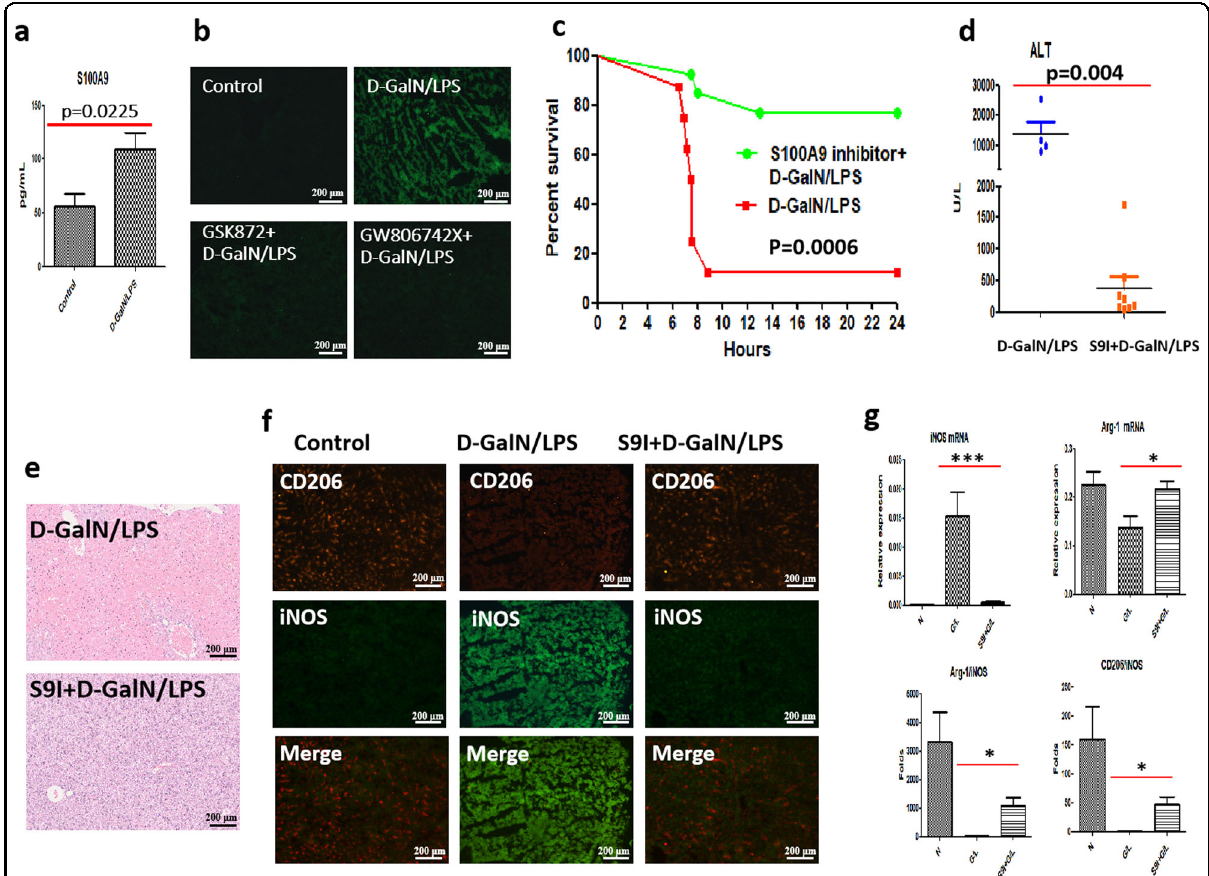
Fig. 3 The inhibition of S100A9, a downstream player of necroptosis signaling, alleviates acute hepatic injury, which is relevant to M2-like activation of macrophages. a Serum S100A9 levels in control and acutely injured mice. ( n = 6) b Comparison of S100A9 expression in the livers of acutely injured mice with or without necroptosis inhibitors. c Comparison of survival rates in acutely injured mice with or without S100A9 inhibitor. ( n = 8 – 13) d The hepatic damage assessed by serum ALT levels in mice challenged by D-GalN/LPS with or without S100A9 inhibitors. ( n = 5 – 8) e The hepatic damage assessed by histopathology with H&E staining in mice challenged by D-GalN/LPS with or without S100A9 inhibitors. f M1 macrophage activation marker iNOS and M2 macrophage activation marker CD206 expression in mice receiving D-GalN/LPS insult with or without S100A9 inhibitors. g M1 (iNOS) and M2 (Arg-1 and CD206) macrophage activation markers were assessed and compared by real-time PCR in mice receiving D-GalN/LPS insult with or without S100A9 inhibitors. * P < 0.05, *** P < 0.001. ( n = 4 –